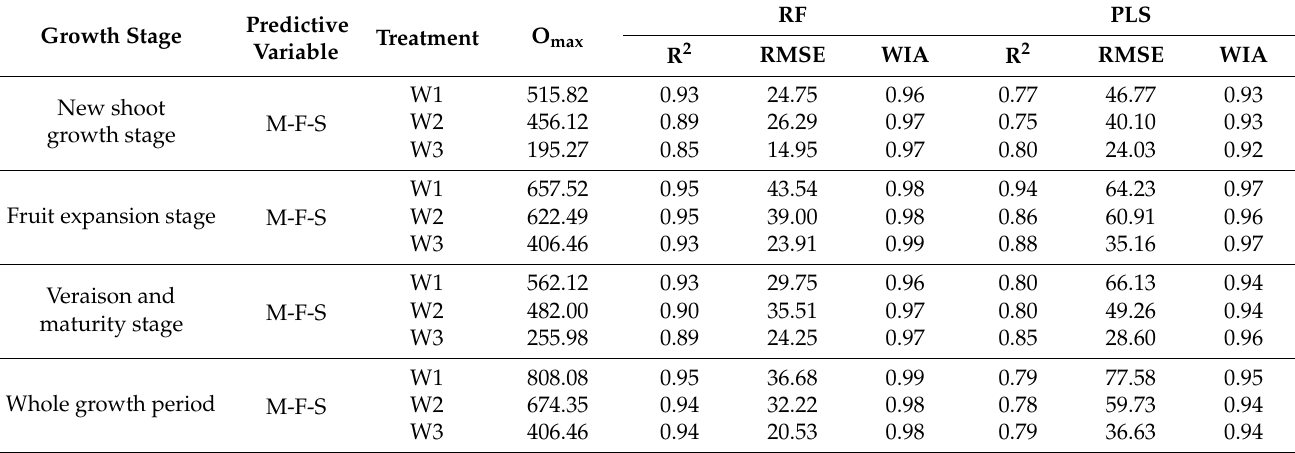
Table 2. Analysis of prediction results of different grape sap flow rate models with M-F-S.